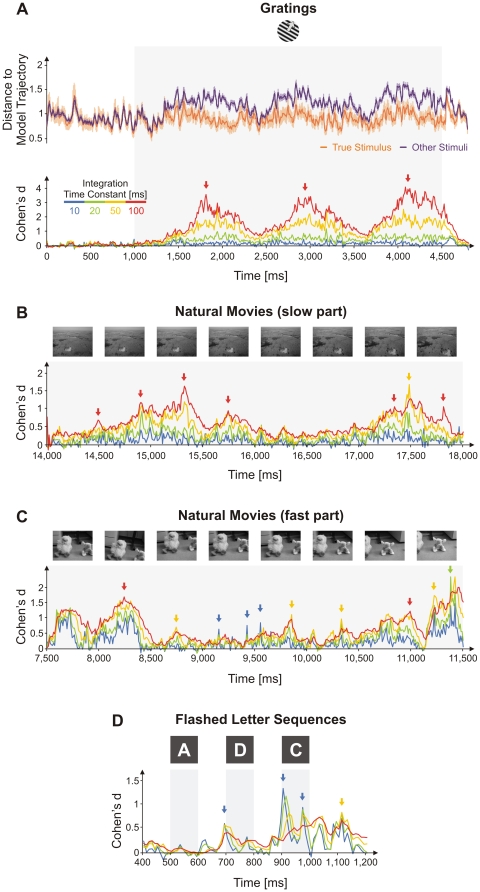
Time of occurrence and timescale of informative patterns.(A) Trajectory analysis on drifting grating stimuli. Top inset: Average distance from trajectories on test trials of a given stimulus to the model trajectory of the true stimulus (orange) and the model trajectories of other stimuli (magenta). τ = 20 ms. Cohen's d between the two distance traces for different integration time constants, τ, for grating stimuli (bottom inset in (A)), slow (B) and fast (C) segments of natural movies, and a flashed letter sequence (D). Light gray bands indicate stimulus presentation periods. Error bars on distance traces in (A) are s.e.m.